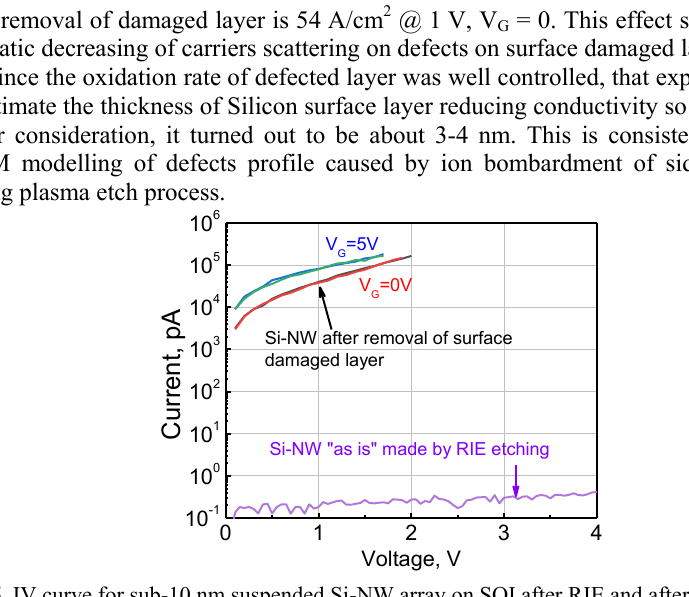
Fig. 5. IV curve for sub-10 nm suspended Si-NW array on SOI after RIE and after removal of damaged surface